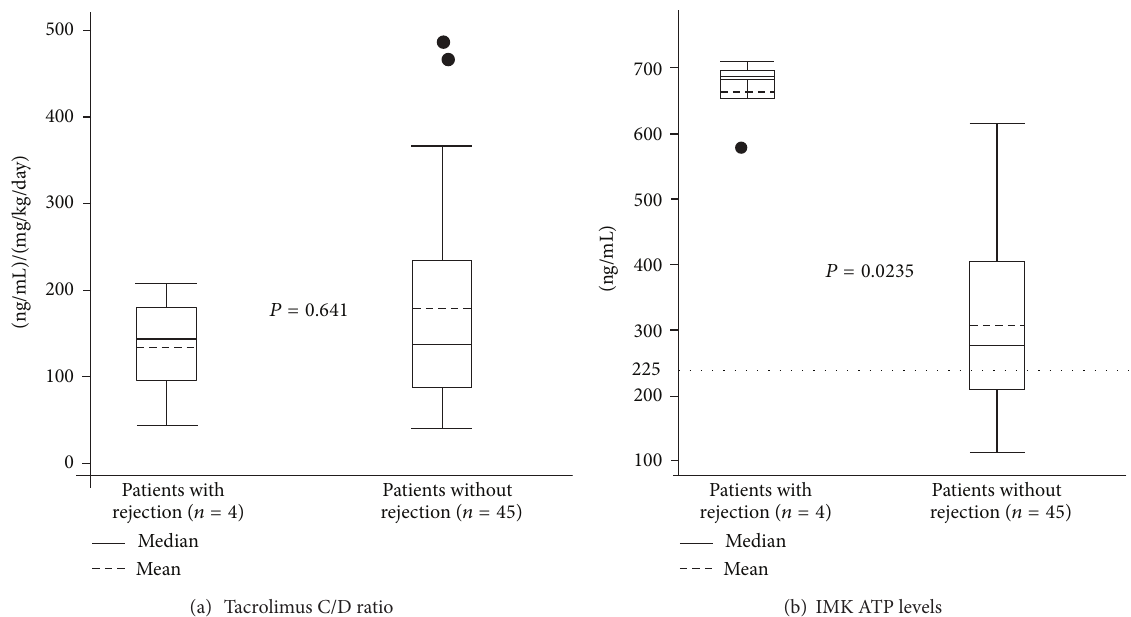
Figure 3: IMK ATP levels and tacrolimus C/D ratio in patients with or without rejection. (a) 134.1 ± 71.9 (range 112–312) ng/mL and 179.2 ± 133.6 . (b) The ATP was 663.2 (range 569–709) ng/mL and 306.6 (range 146–615) ng/mL, respectively.